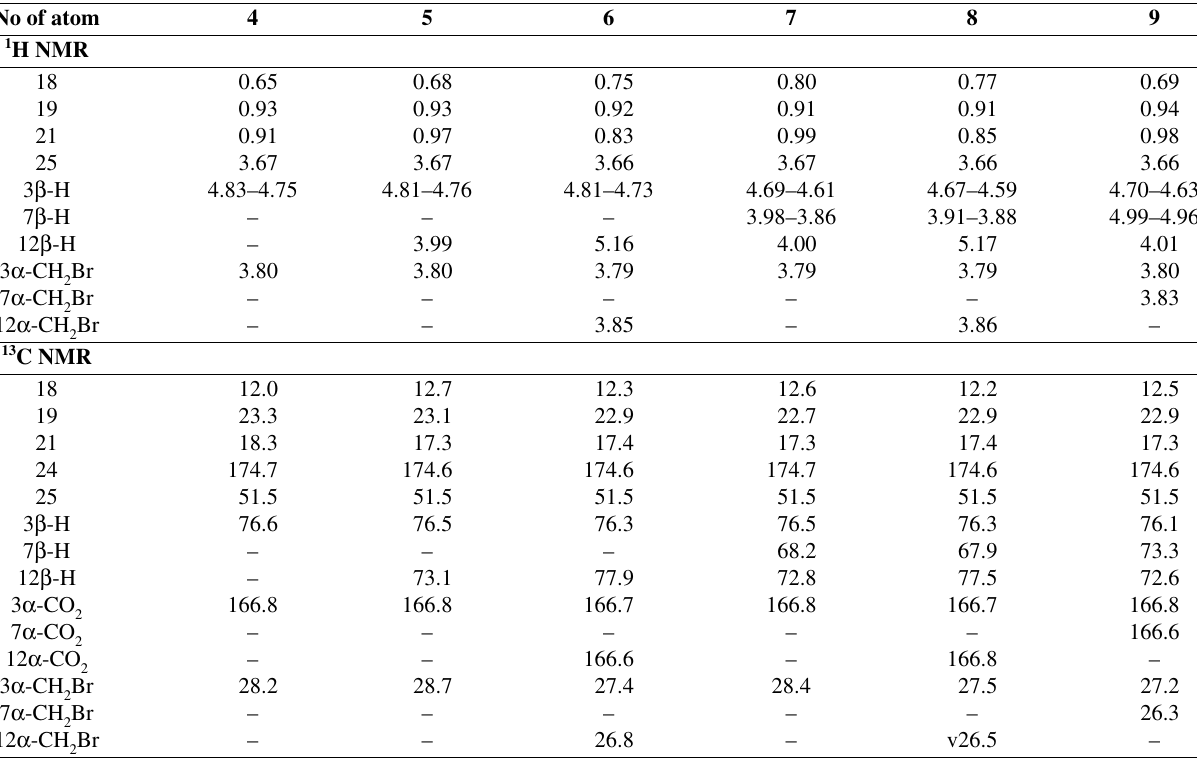
Table 3. The most characteristic chemical shifts (ppm) in 1 H and 13 C NMR spectra of compounds 4 – 9 . No of atom